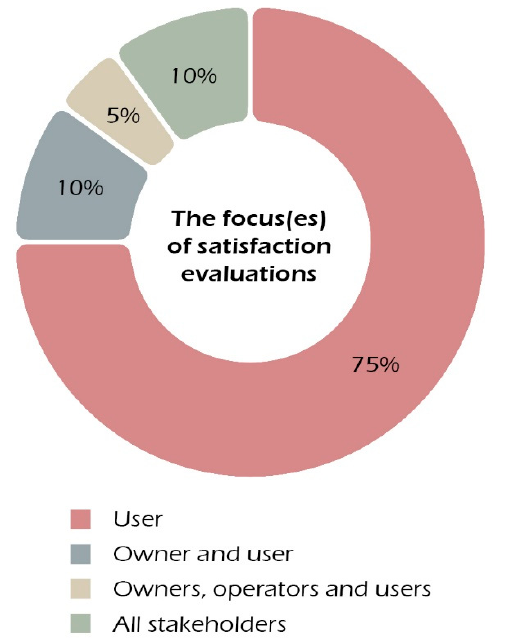
Figure 10. The percentage of the groups emphasised by the definitions which adopt the satisfaction model.